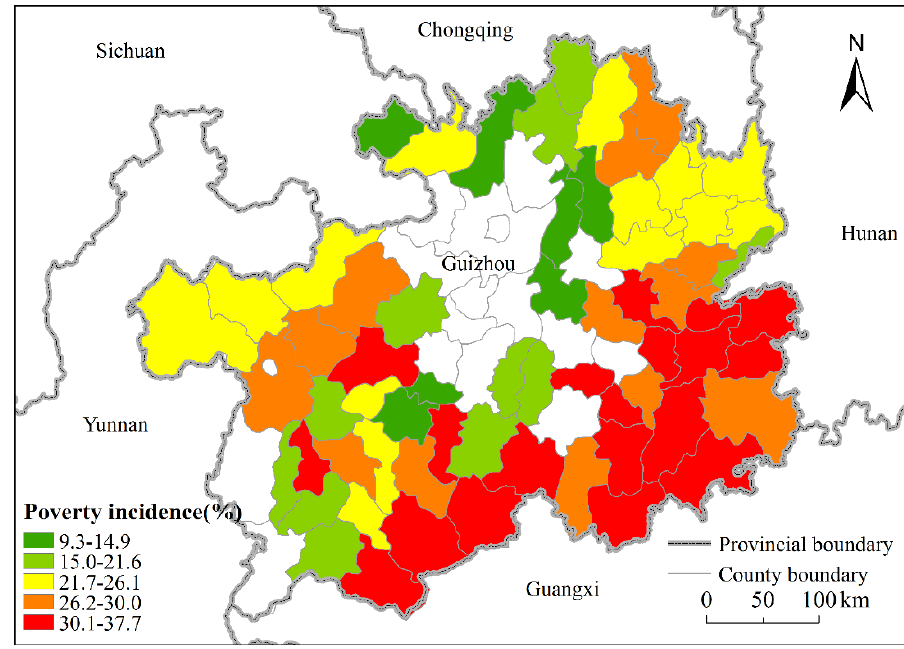
Figure 5. Spatial distribution of county-level poverty incidence in Guizhou Province in 2013.